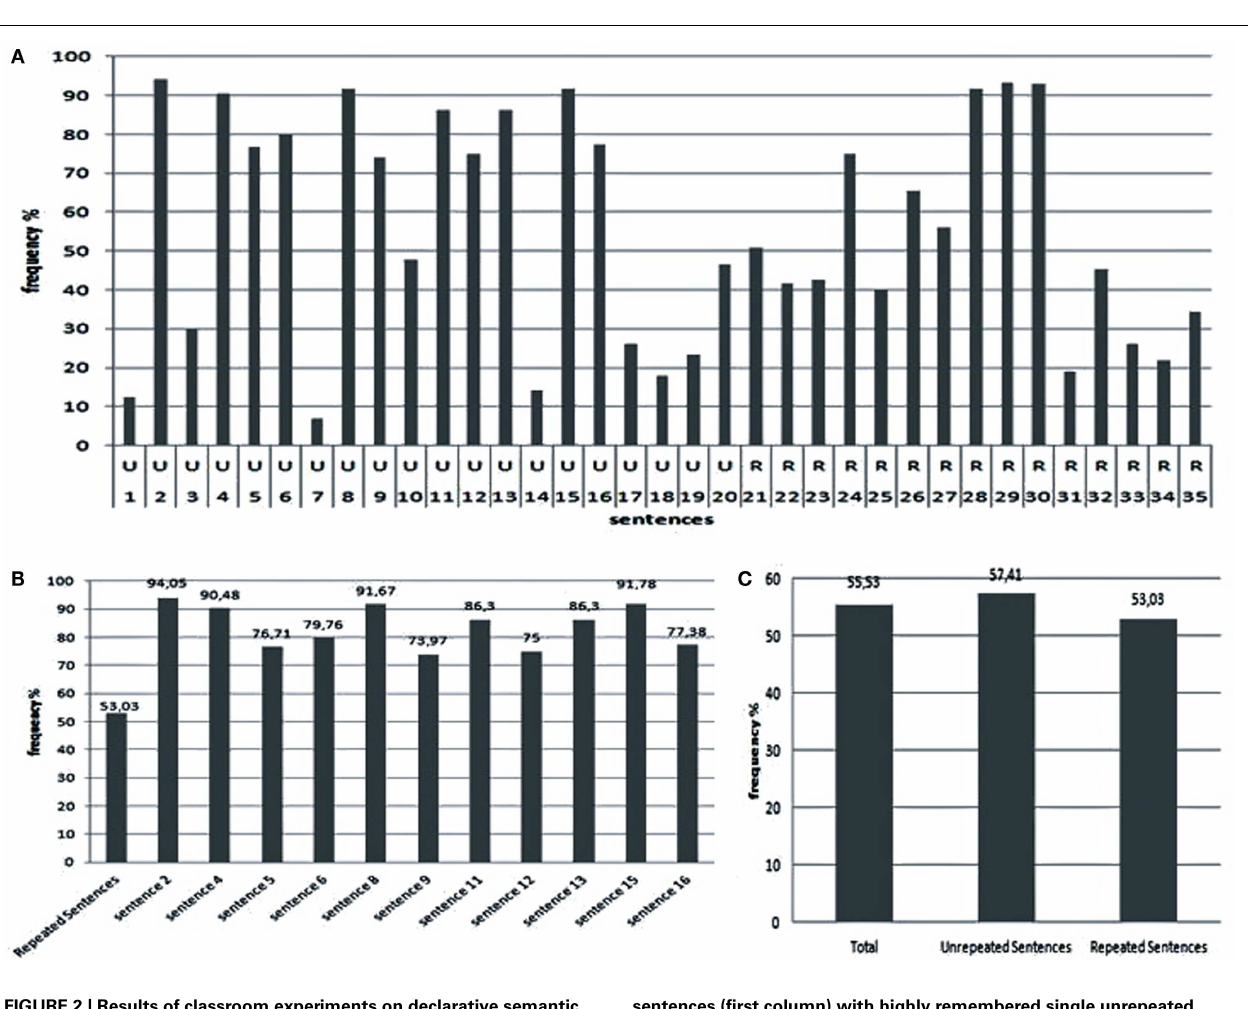
sentences (first column) with highly remembered single unrepeated relevant sentences; (C) comparison of average frequency of correct answers for repeated irrelevant against unrepeated relevant and irrelevant sentences